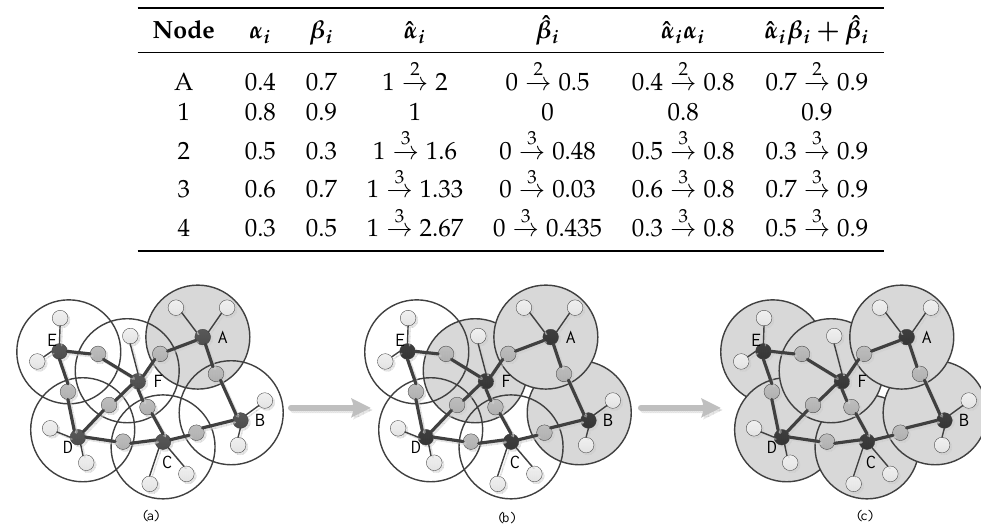
Table 3. Clock Parameters Update after Sync.